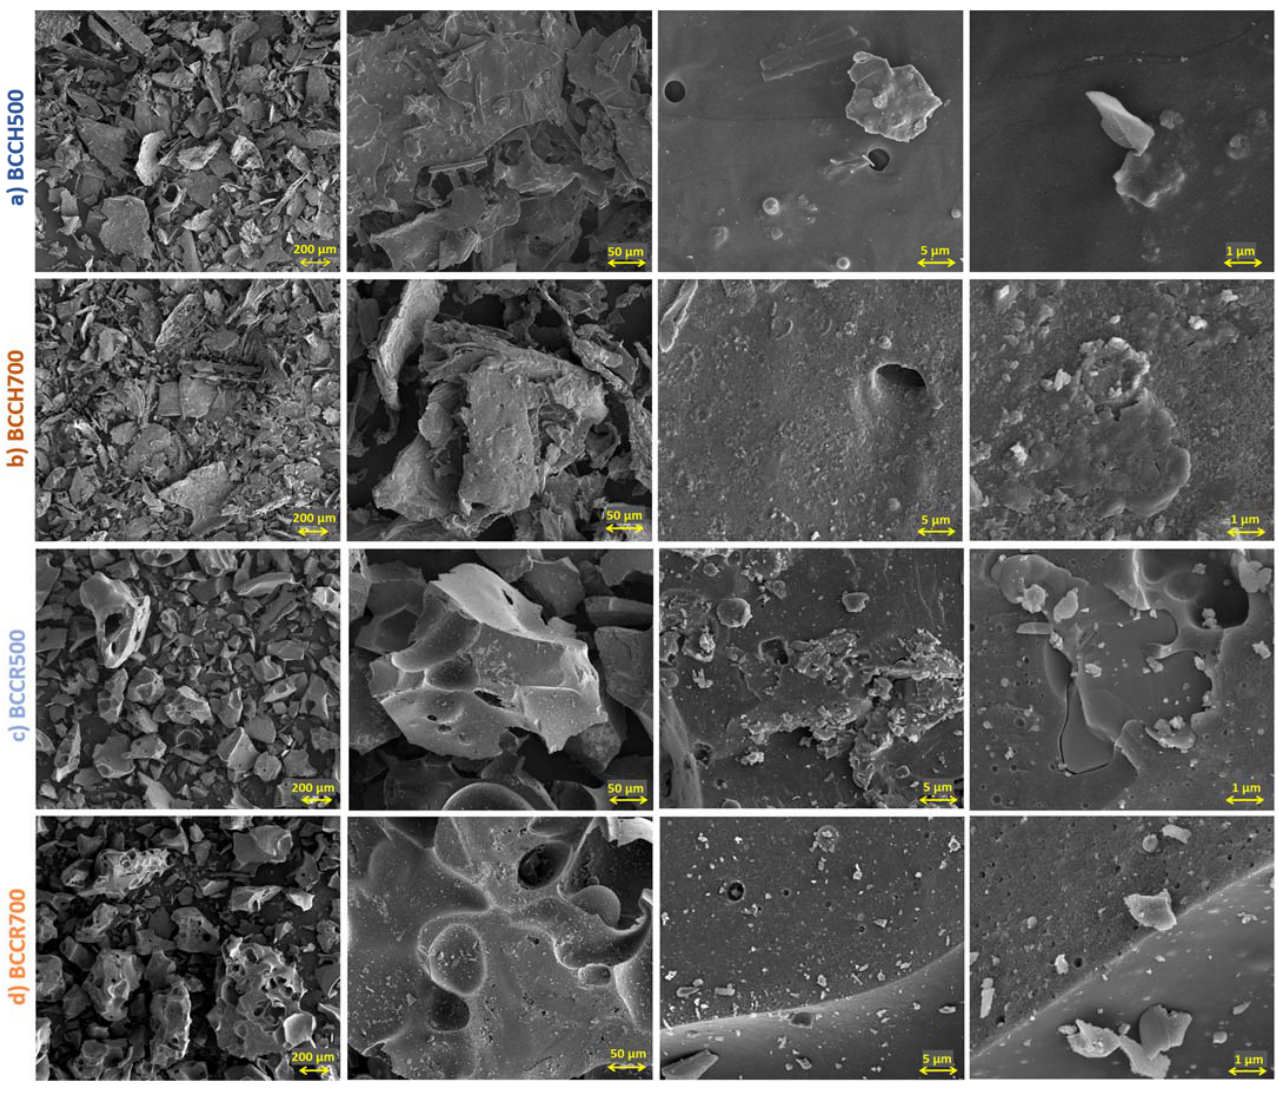
Figure 1. SEM images of BC particles at rows: ( a ) BCCH500; ( b ) BCCH700; ( c ) BCCR500 and ( d ) BCCR700 at different magnification from left to right 100 × ; 500 × ; 5000 × ; 20,000 × , respectively. Table 1. BC elemental analysis from SEM–EDX data.